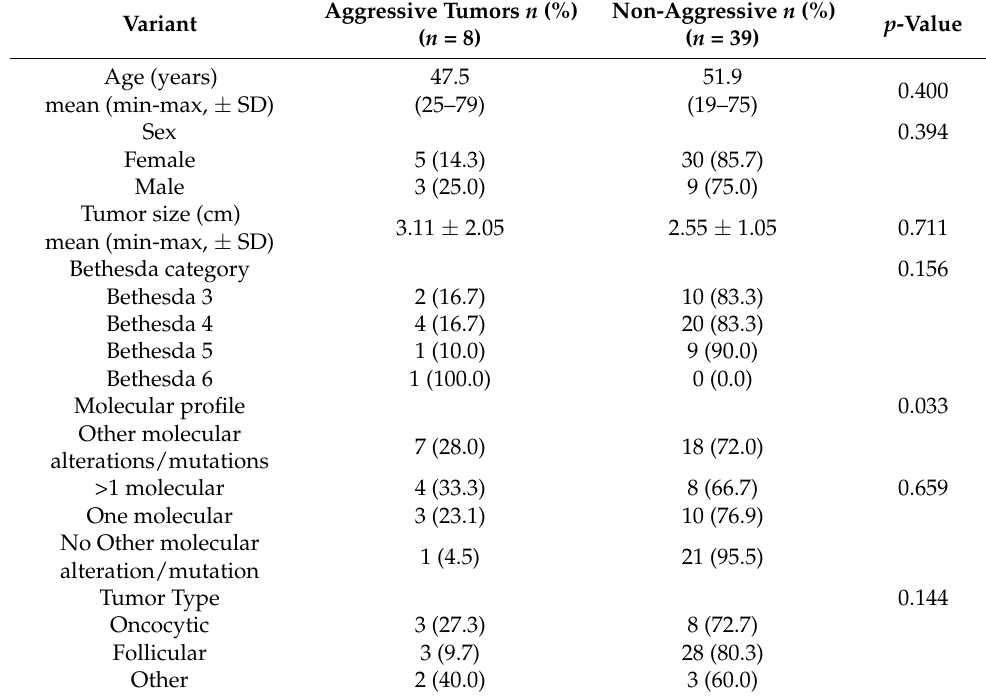
Table 3. Association between aggressive tumors and clinicopathological characteristics in the 47 pa- tients with thyroid